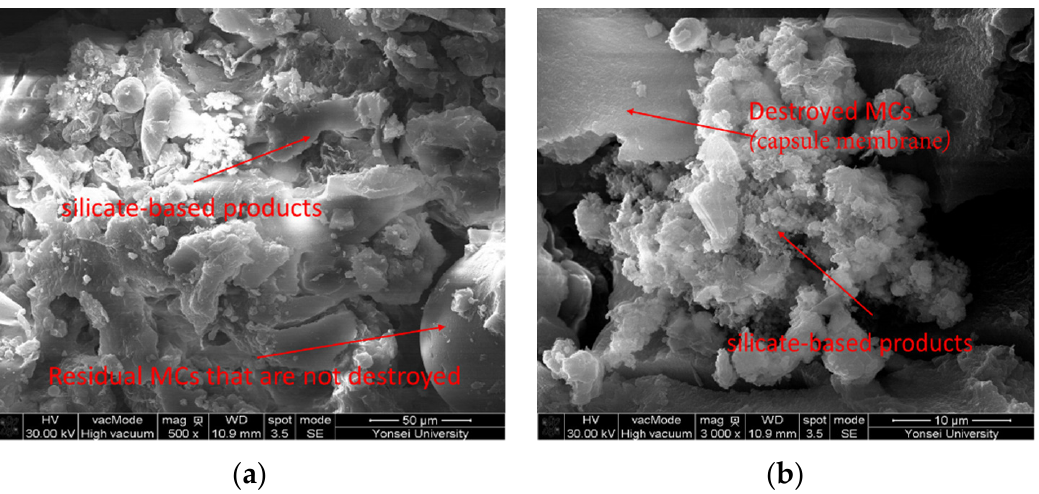
Figure 21. Observation result of healing area: ( a ) ×500; ( b ) ×3000.